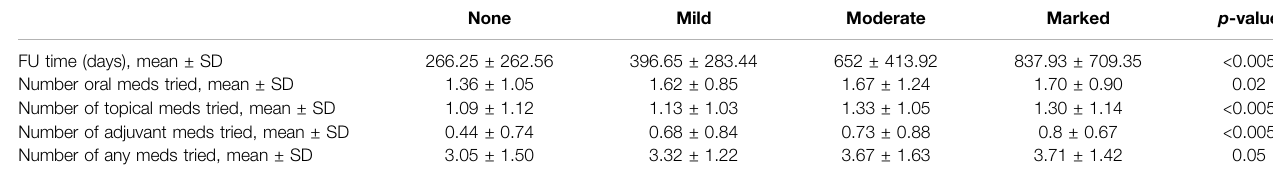
TABLE 4 | Population-wide Differences in Mean Follow-up Time and Medications Attempted Between Different Categories of Clinical Improvement with Treatment . None Mild Moderate Marked p